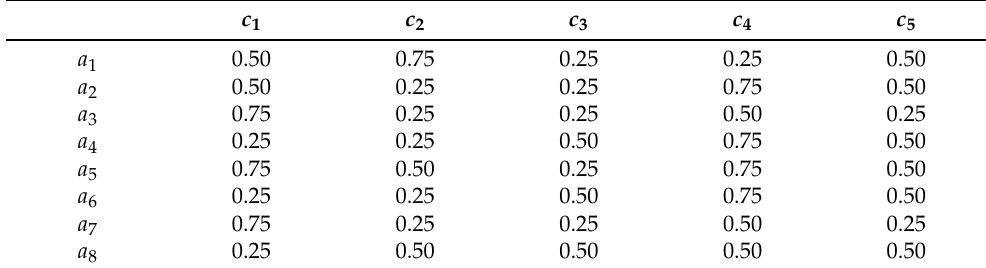
Table 1. A information system of rough